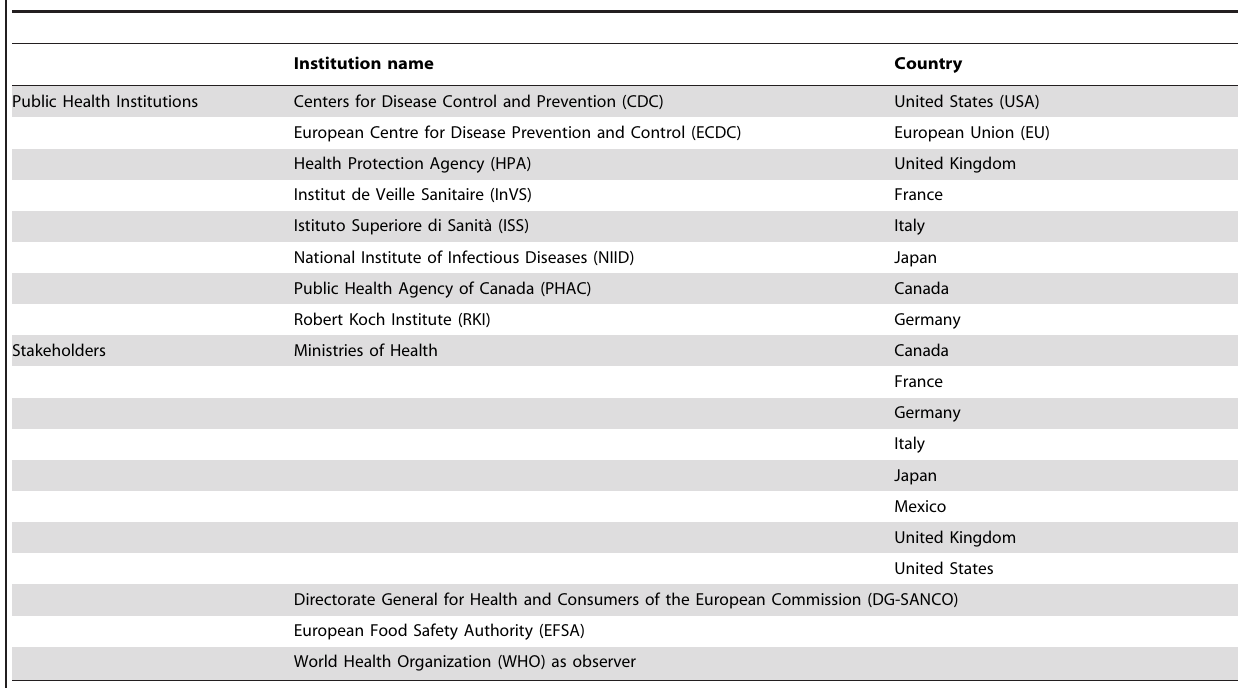
Table 2. Early Alerting and Reporting (EAR) public health institutions and